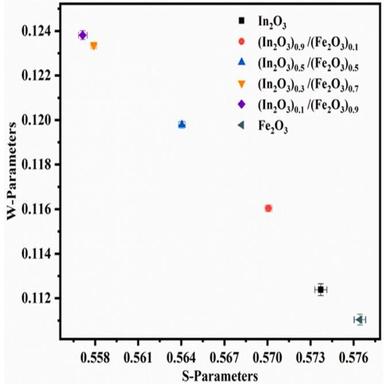
Relationship between S and W for all samples at fixed incident positron energy E (eV).